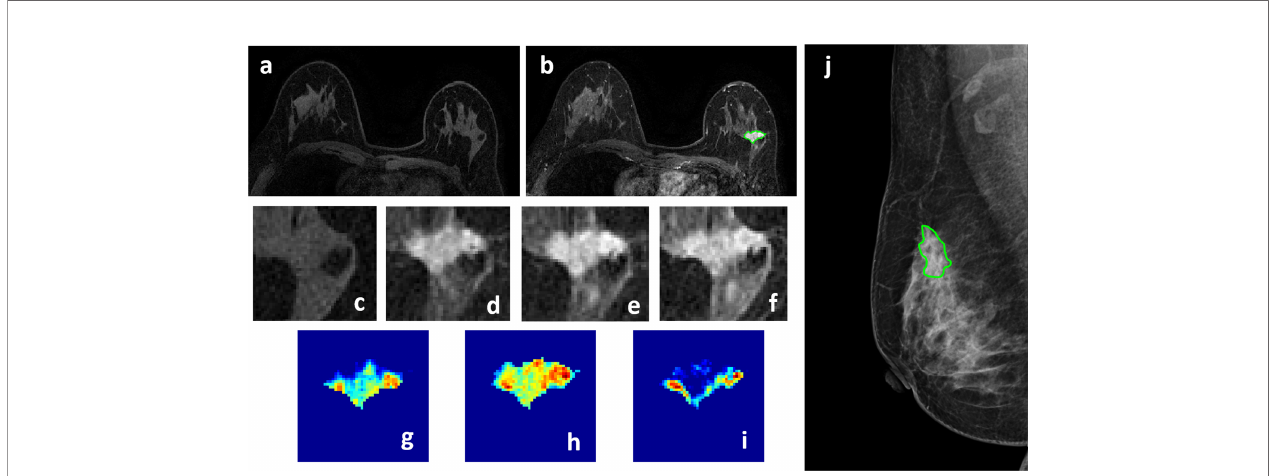
FIGURE 2 | A 50-year-old patient with invasive ductal cancer, showing a strongly enhanced 1.8 x 1.0 cm lesion, with MRI BI-RADS score of 5. (A) F1 Pre-contrast image. (B) F2 post-contrast image. (C – I) Magni fi ed images to demonstrate the margin and internal enhancements within the lesion. (C) F1 pre-contrast, (D) F2 post- contrast, (E) F3 post-contrast, (F) The last F6 post-contrast image. (G) The wash-in signal enhancement map F2-F1, (H) The F3-F1 signal enhancement map, (I) The wash-out F6-F3 map. (J) A mass lesion with spiculation is clearly noted on mammography as BI-RADS 4C, and manually outlined by a radiologist. The